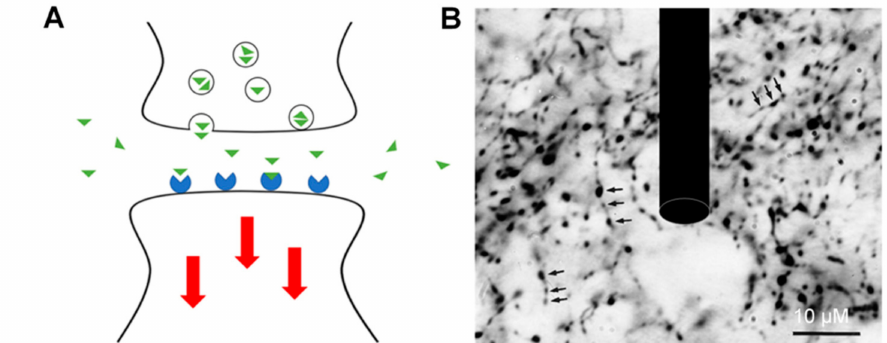
Figure 1. ( A ) Neurotransmitters (green) are exocytotically released into the synaptic cleft and di ff use into the extracellular matrix, bind to the receptors (blue), and trigger a series of downstream reactions (red) in the axon of other neurons. ( B ) A model electrode drawn to scale in a network of neurons. Adapted from